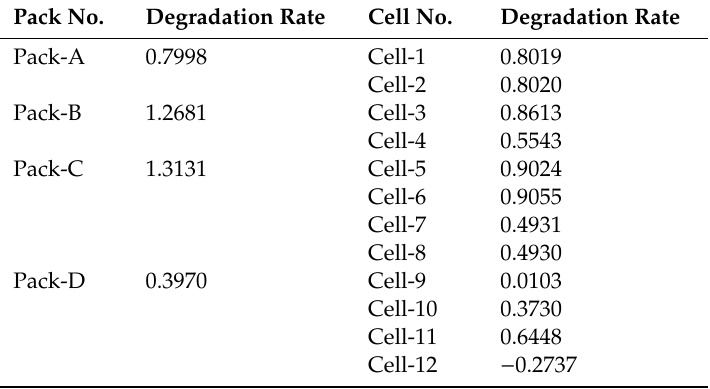
Table 7. Capacity degradation rates of the battery packs and